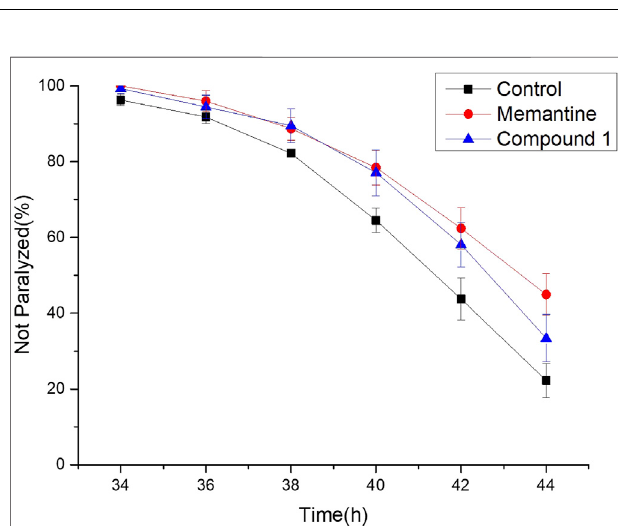
FIGURE 6 | Anti-Alzheimer ’ s disease (AD) activity of compound 1 , positive control, and control. Worms were treated with 100 μ M compound 1 , 100 μ M memantine was regarded as the positive control, and 0.1% DMSO was regarded as the